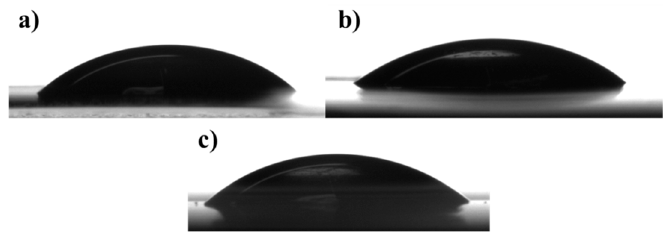
Figure 3. Water drops deposited on the film surface of: ( a ) SA 0.15 ; ( b ) Pe 0.15 ; ( c ) SA+Pe 0.15 .